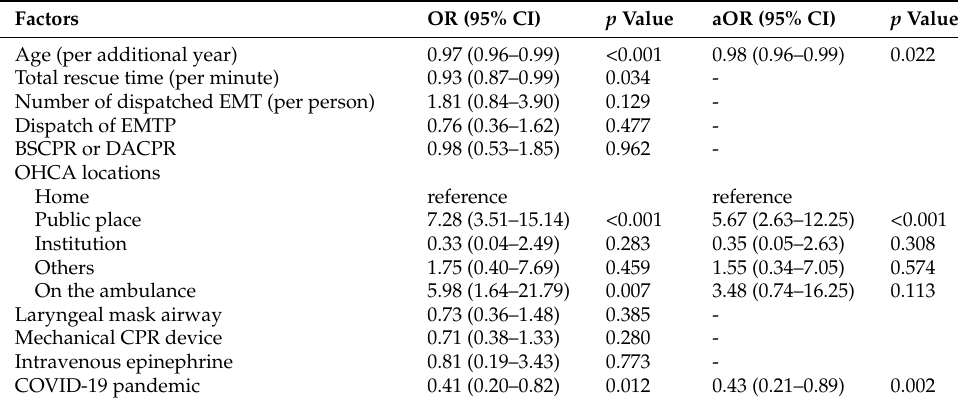
Table 4. Predictive factors of accomplishing survival to discharge.